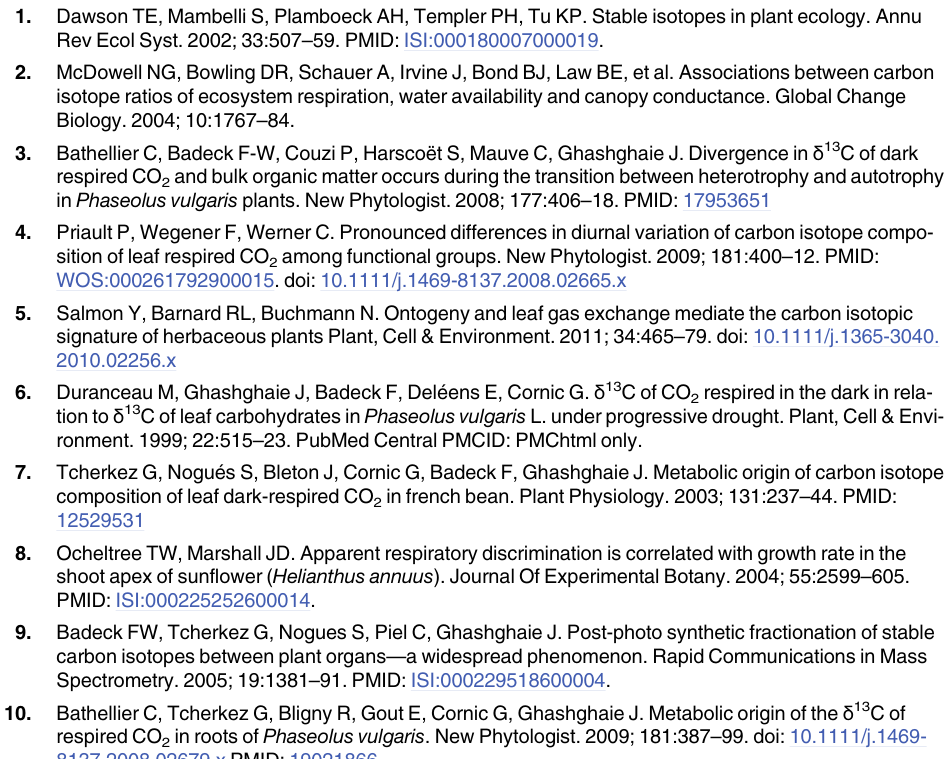
S2 Table. ANOVA results for R S3 Table. Respiratory C isotope fractionation ( Δ cies. S4 Table. Estimated average daily C balance of